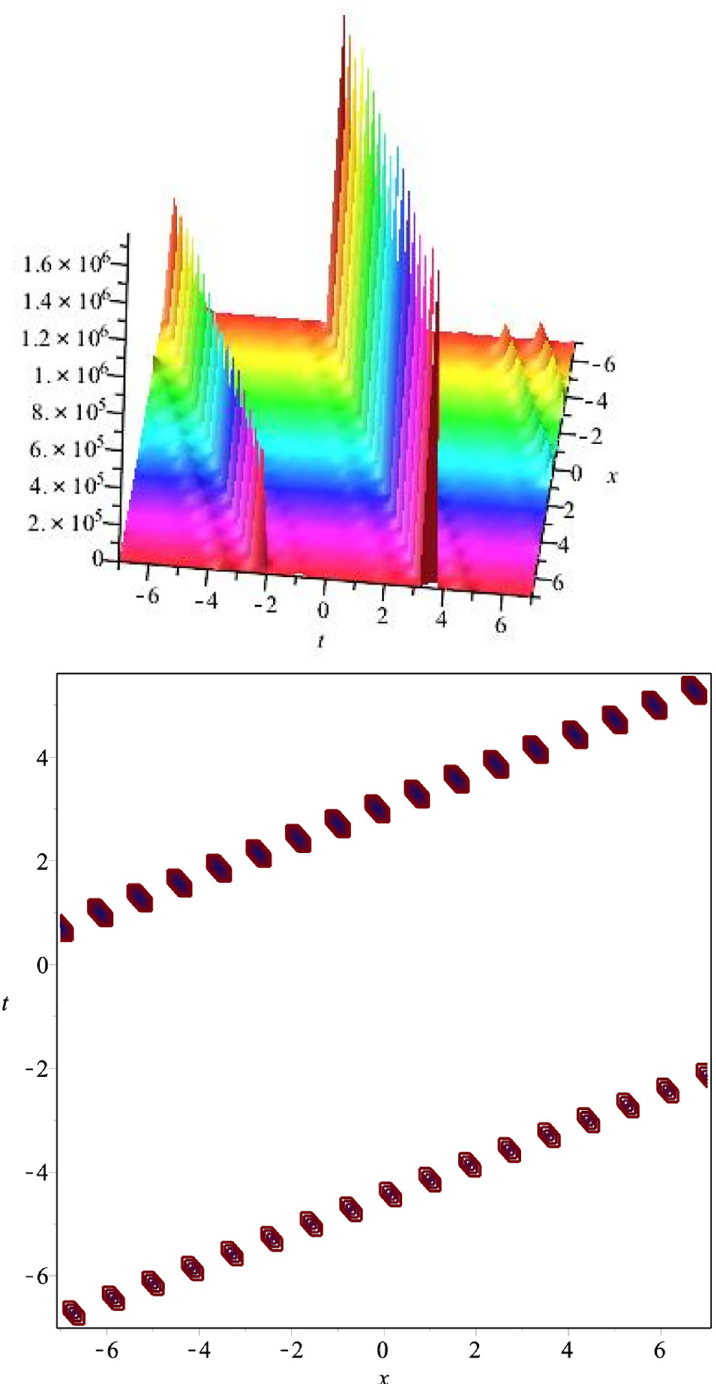
Fig 3. Singular soliton: j v 6 ( x , t ) j for l = 3.1, m = 4.2, λ = 1.8, c = 3.8, v = 3, μ = 3.6.